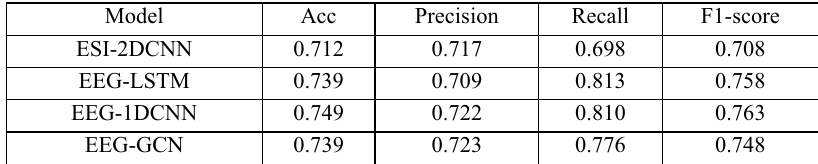
Table 1. Performance of different Deep Learning model.